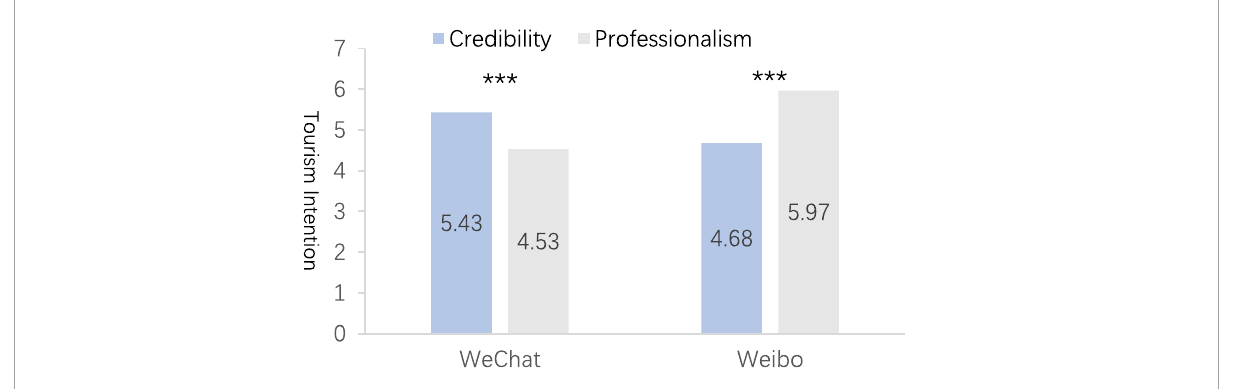
FIGURE1 The influence of information source types of internet celebrity tourism attractions on the tourism intention of potential tourists. ∗∗∗ p < 0.01.